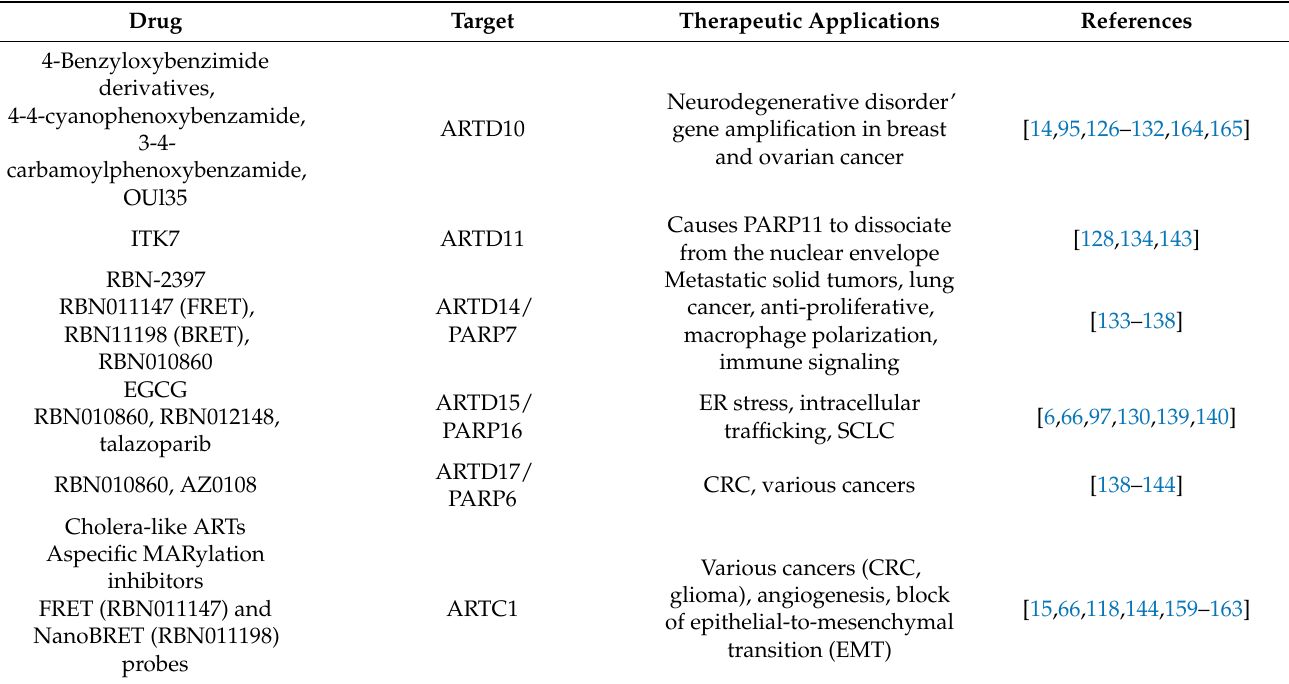
Table 4. Other MARylating ART enzymes: potential inhibitors applied to cancer treatment. Drug Target Therapeutic